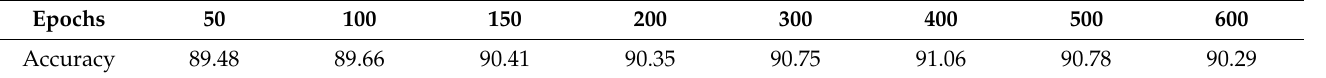
Table 2. Accuracies with different numbers of epochs.